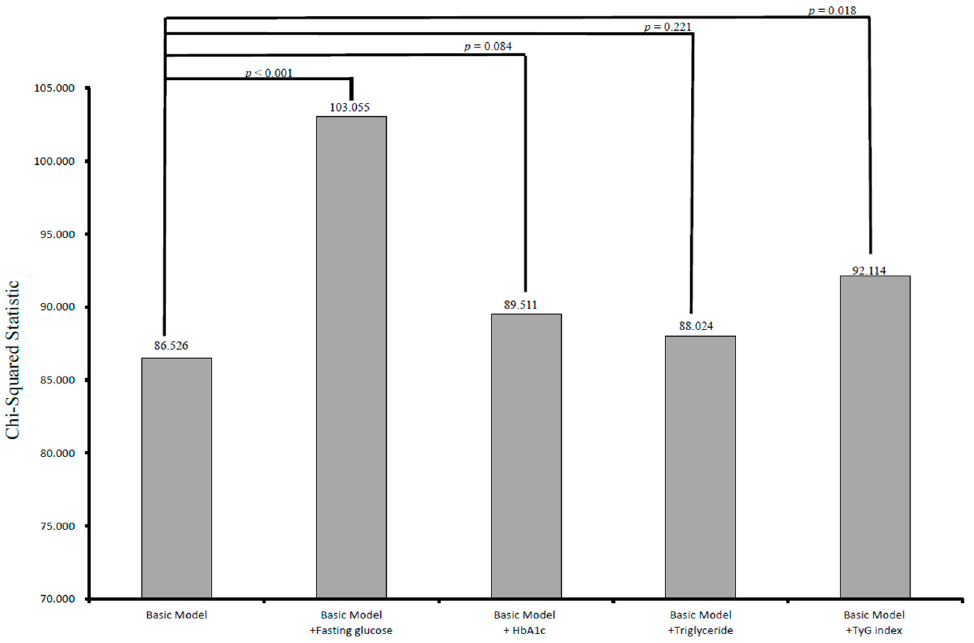
Figure 2. Comparison of the prediction power of addition of fasting glucose, hemoglobin A 1c , triglyceride, and the TyG index to a basic model in the prediction of increased cardiovascular events. Addition of fasting glucose and TyG index resulted in a significant improvement in the prediction of increased cardiovascular events ( p < 0.001 and p = 0.018, respectively), but hemoglobin A 1c and triglyceride ( p = 0.084 and p = 0.221, respectively) did not.